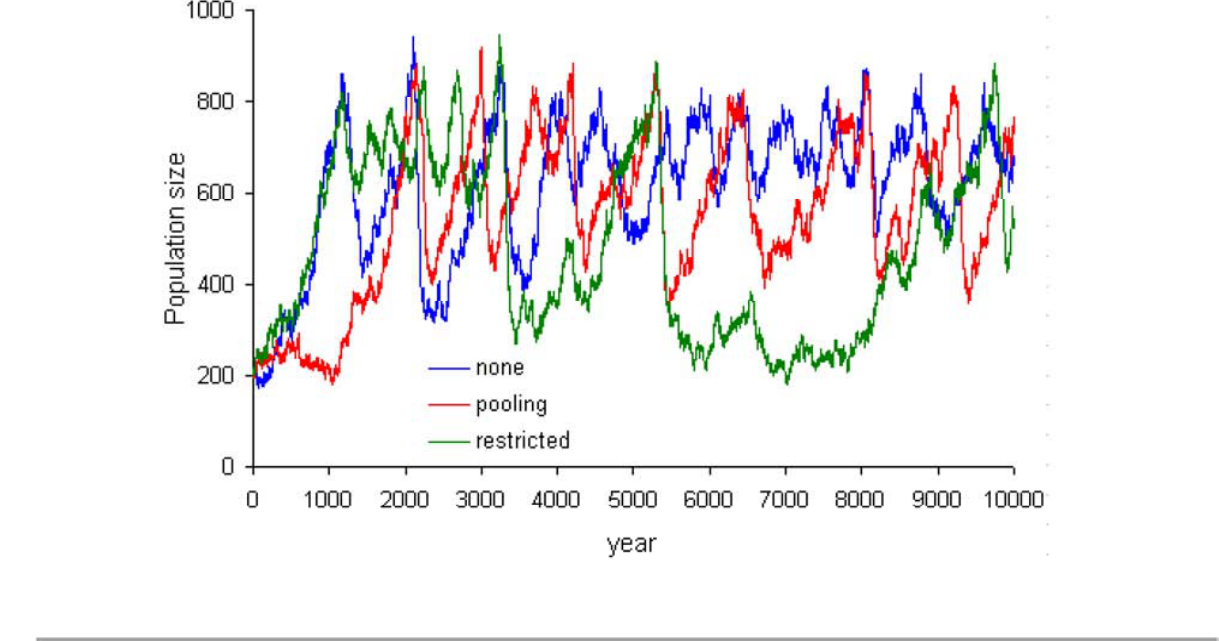
Fig. 4. Population sizes for typical runs for three types of sharing mechanisms within the